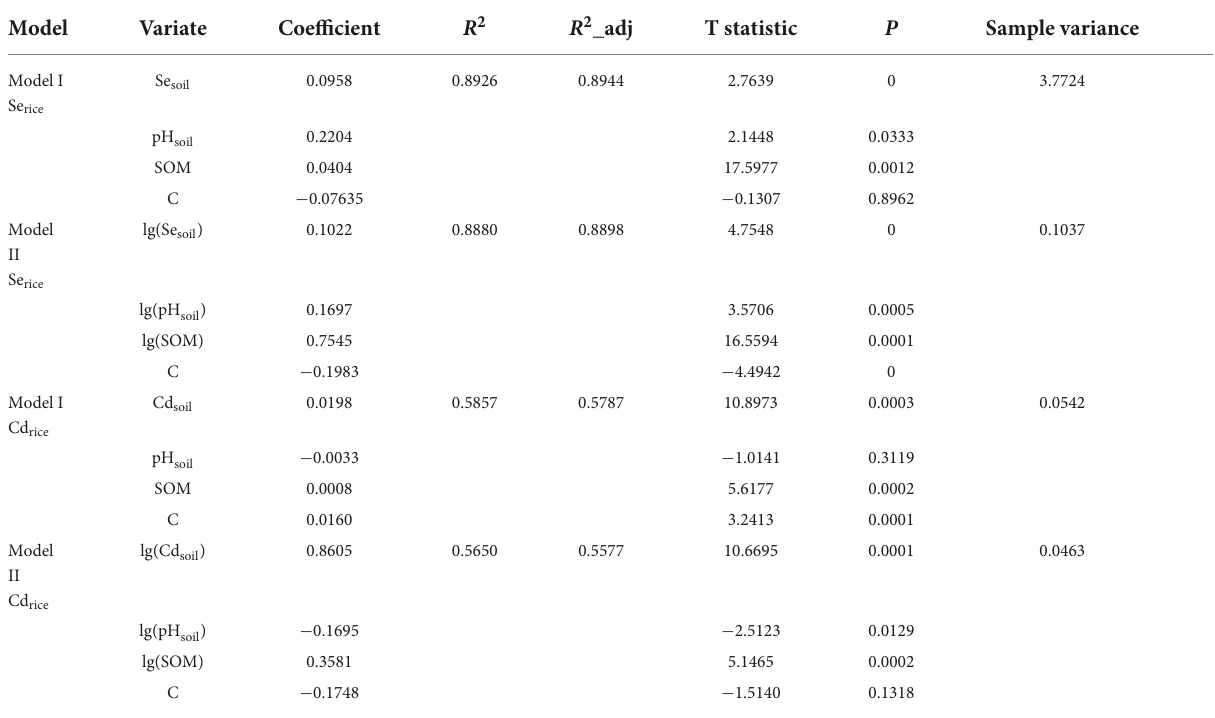
TABLE 2 Prediction models of Se and Cd accumulation in Se-rich rice